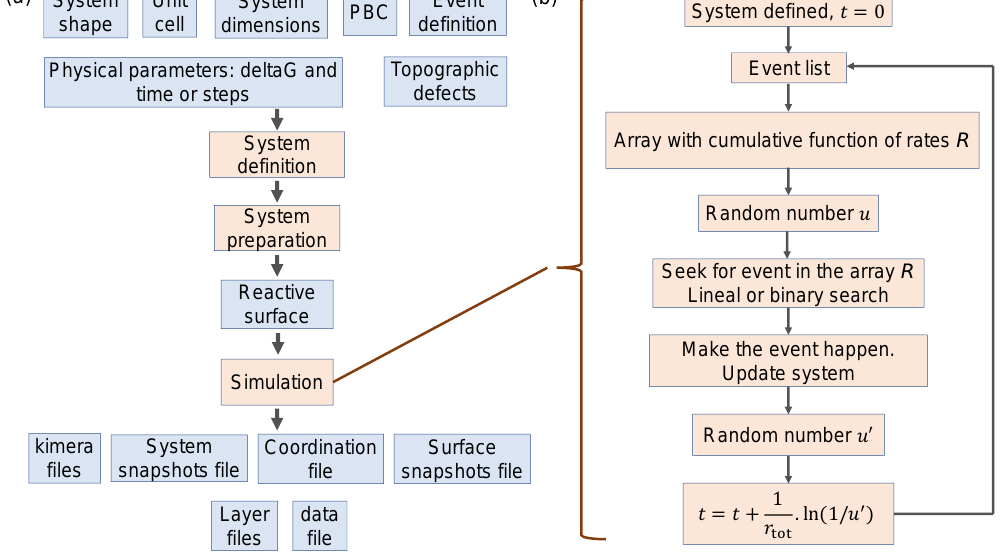
Figure 1. ( a ) KIMERA (Kinetic Monte Carlo for Mineral Dissolution) workflow. ( b ) KMC (Kinetic Monte Carlo)